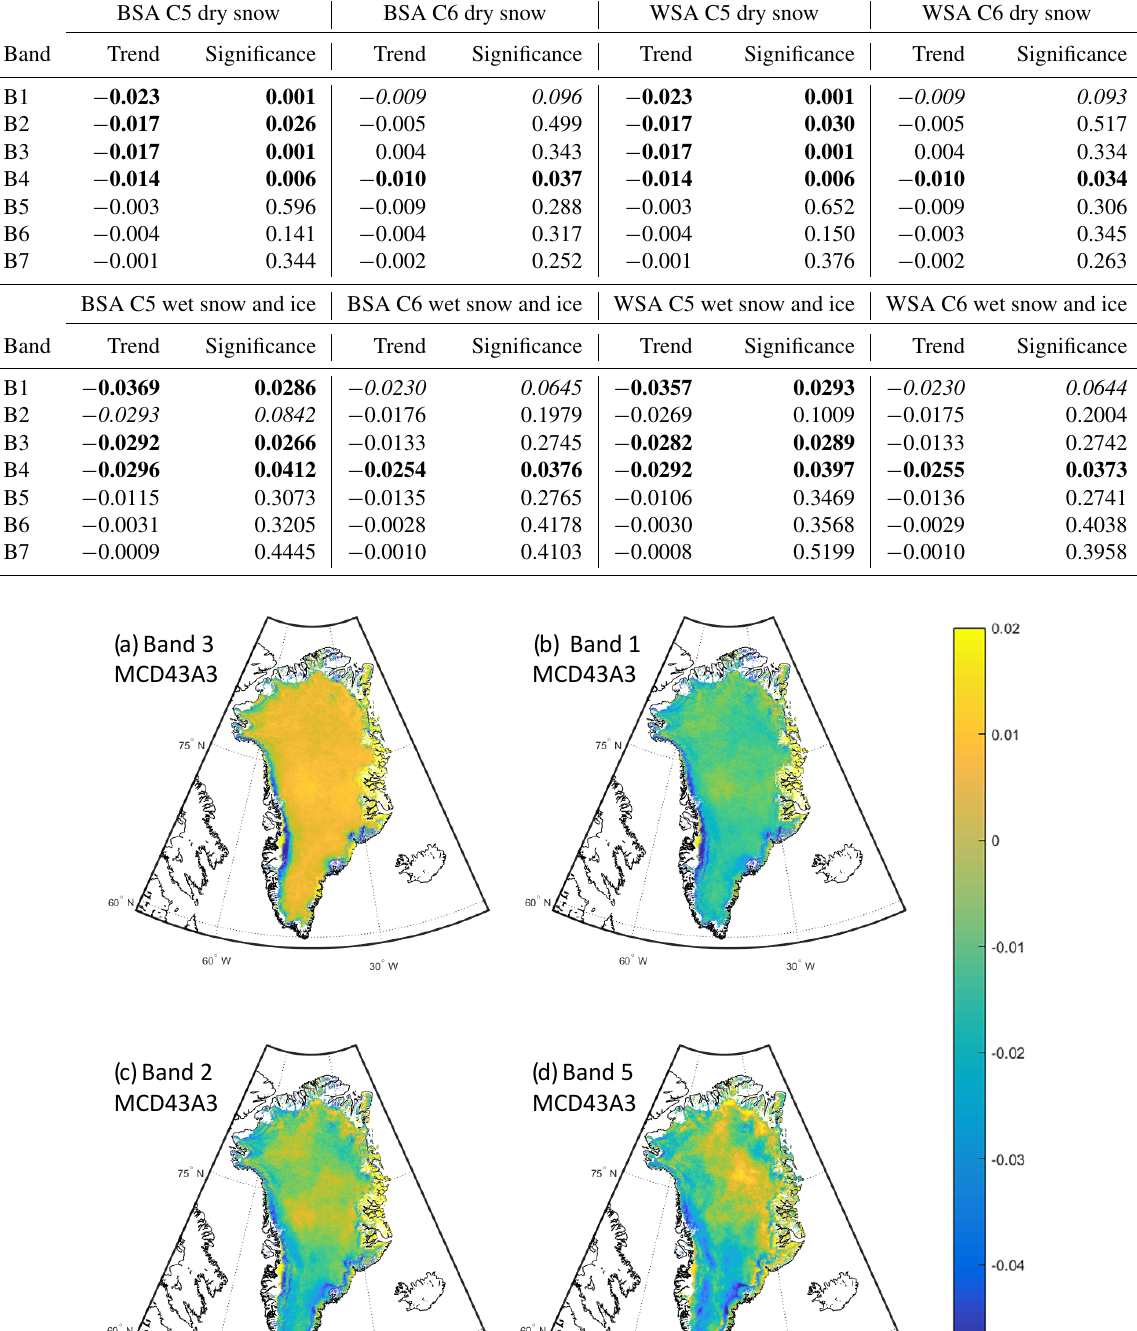
Table 3. Trends (decade − 1 ) and statistical significance of trends for MCD43A3 directional hemispherical reflectance (or black-sky albedo, BSA) and bihemispherical reflectance (or white-sky albedo, WSA). Statistically significant (where p ≤ 0.05) trends are in bold, and marginally significant trends (where p = 0.05 to 0.1) are in italics.